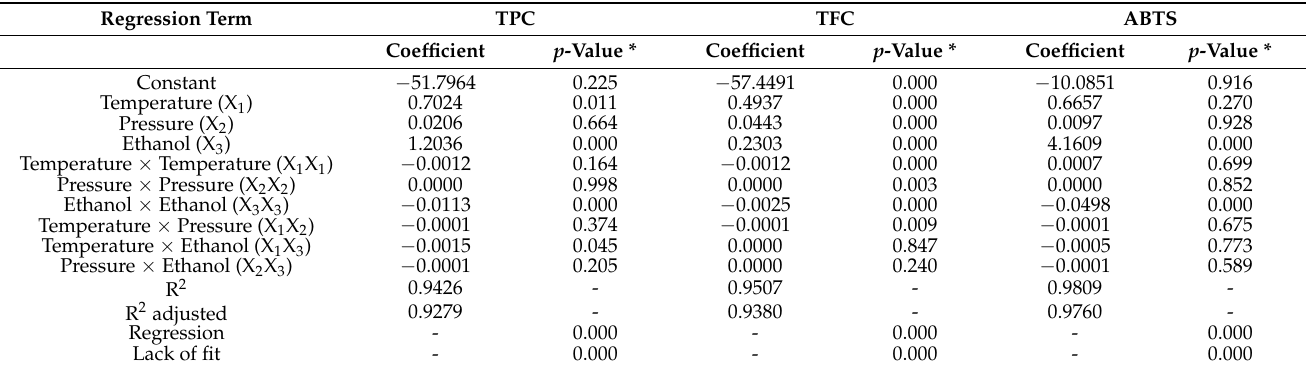
Table 2. Regression coefficients, coefficient of determination and p -value of the predicted second- order polynomial models for TPC, TFC and ABTS.